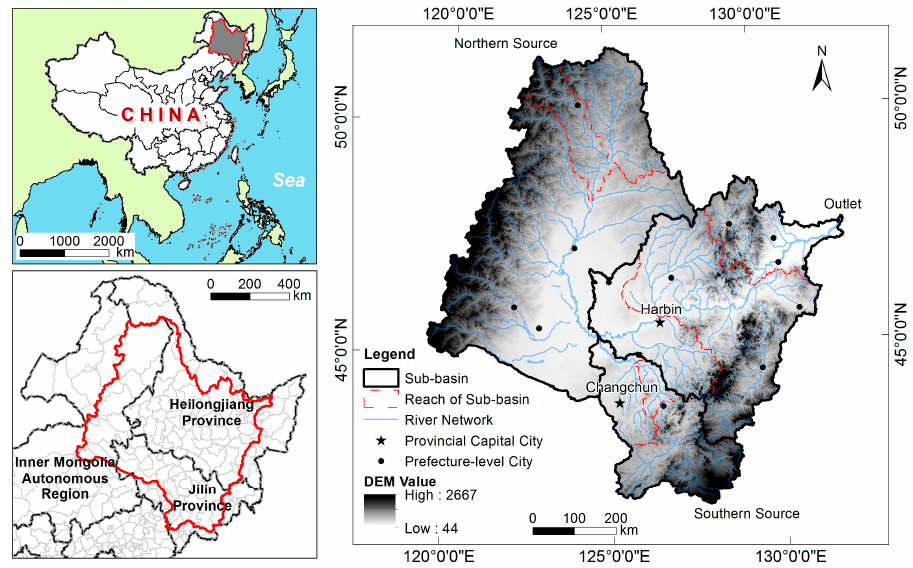
Figure 1. Location of the Songhua River Basin (SRB).